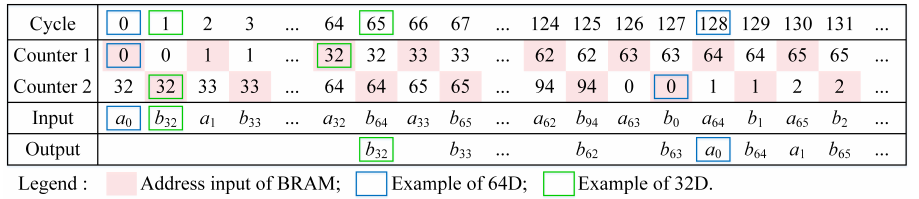
Figure 9: Timing diagram of the BRAM scheme for a 64D/32D unit. a i denotes data passing through 64D, where i denotes the storage address of a i in the BRAM. b j denotes data passing through 32D, where j denotes the storage address of b j in the